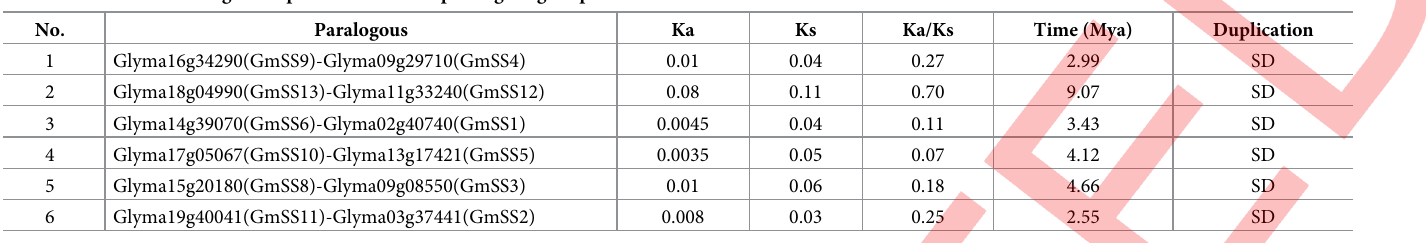
Table 3. Ka Ks values and gene duplication of GmSS paralogous gene